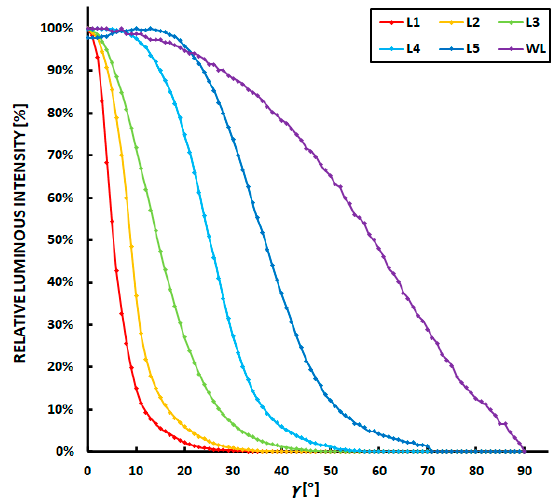
Figure 9. The luminous intensity distribution curves for the selected lenses: L1 (8.5°), L2 (14°), L3 (30°), L4 (45°), L5 (70°), WL (120°).